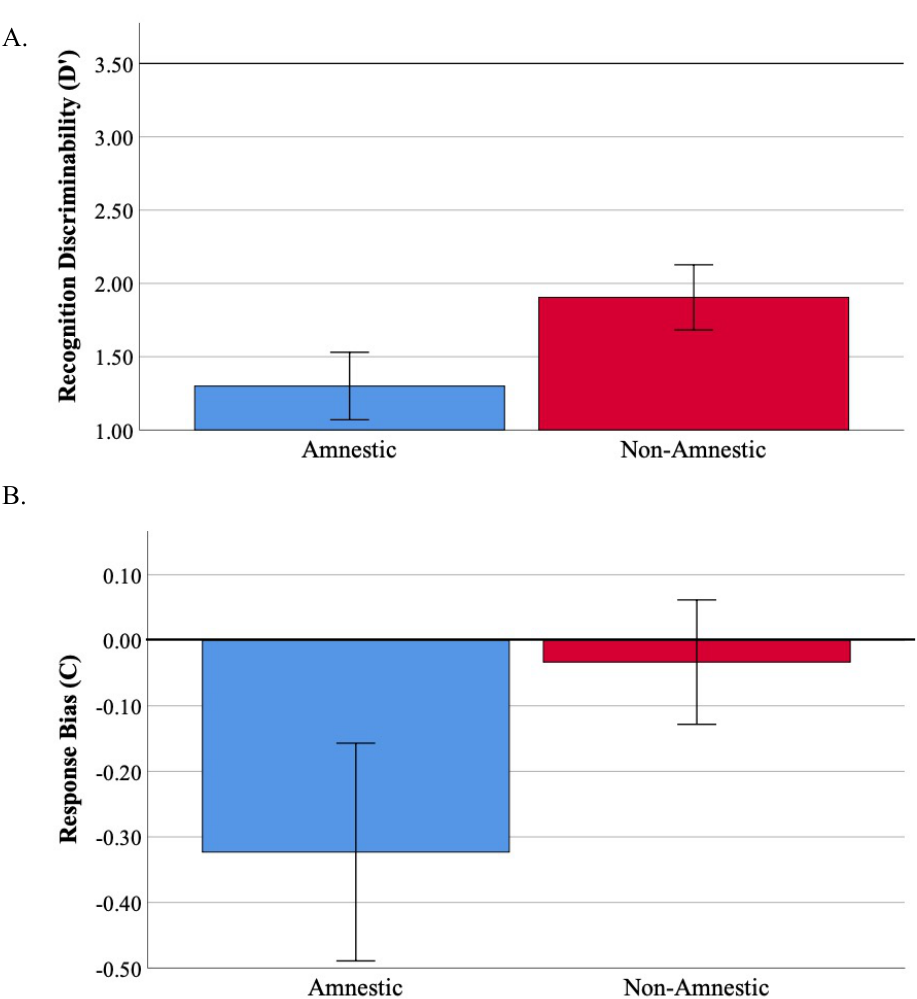
Figure 1. Recognition memory performance in AD. ( A ) Recognition discriminability (d’) is poorer in the amnestic compared to the non-amnestic group at a trend level (t = − 1.8, p = 0.08, Cohen’s d = 0.64), though d’ is poor in both groups (a perfect d’ score is 3.5). ( B ) Response bias (C) is substantially liberal in the amnestic compared to non-amnestic group at a trend level (t = 1.6, p = 0.10, Cohen’s d =